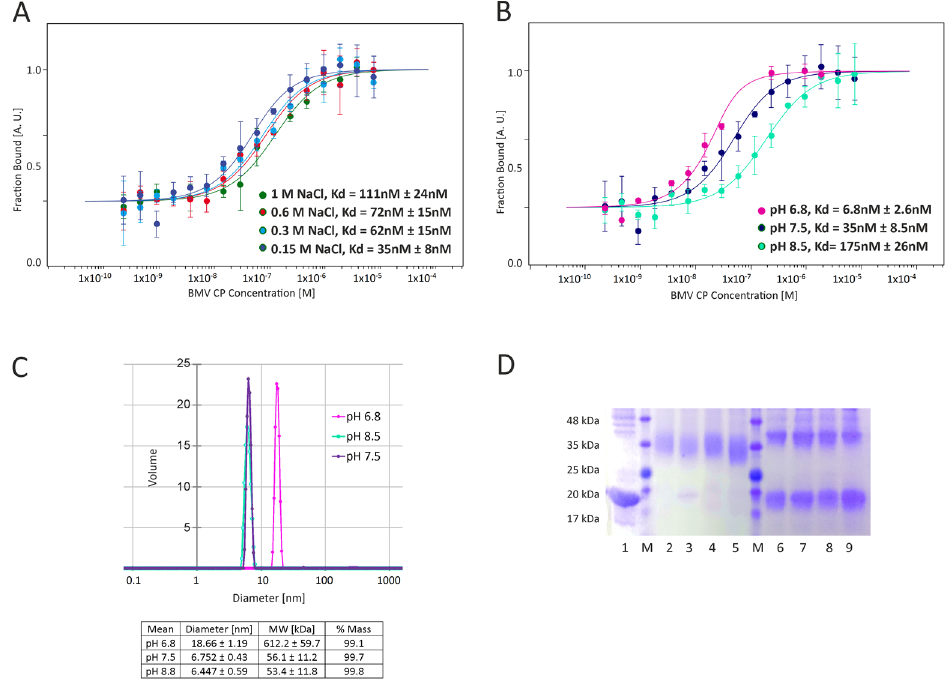
Figure 1. CP-CP affinity analysis in various buffer conditions. ( A ) MST results for the interaction in NaCl gradient. ( B ) MST results for the interaction in pH gradient. The binding curves and the corresponding K d values resulted from the analysis of raw MST data. The curves and K d values estimated from the same measurement are marked with the same colors. ( C ) DLS analysis of rCP hydrodynamic diameter at concentration of 0.1 mg/mL in a pH gradient (volume distribution). The colors of DLS curves correspond to the results from ( B ). ( D ) The cross-linked CP visualized via SDS-PAGE. Lanes: 1—CP without cross-linking, M—molecular weight marker, 2–5—CP crosslinked at pH 7.5 after 5, 10, 15 and 30 min, respectively, 6–9—CP crosslinked at pH 6.8 after 5, 10, 15 and 30 min,